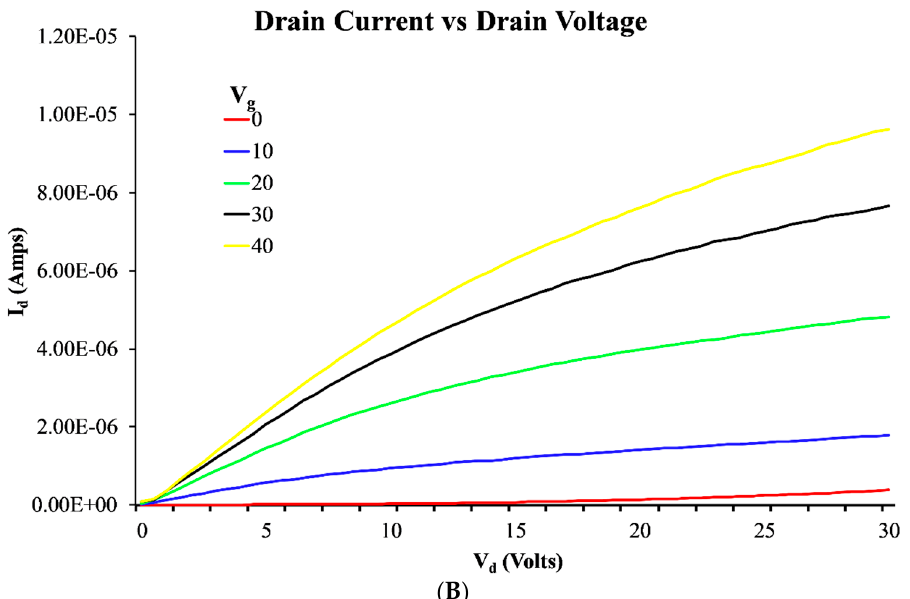
Figure 6. The DC performance curves for the R2R compatible transistor design. ( A ) Drain Current vs Gate Voltage; ( B ) Drain Current vs Drain Voltage.